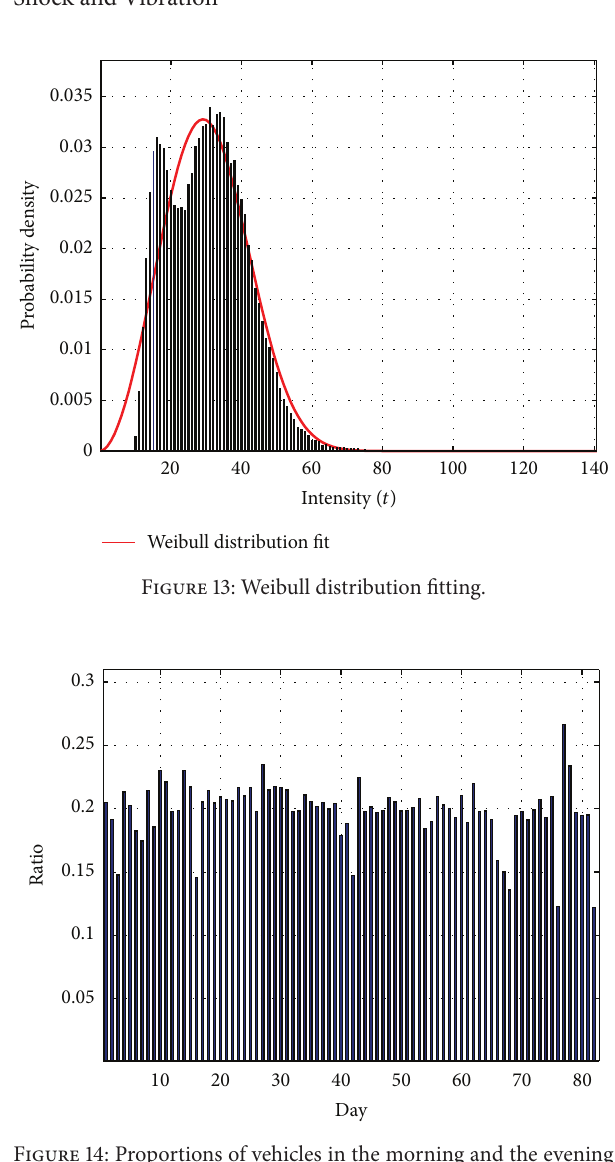
Figure 14: Proportions of vehicles in the morning and the evening rush hour periods.